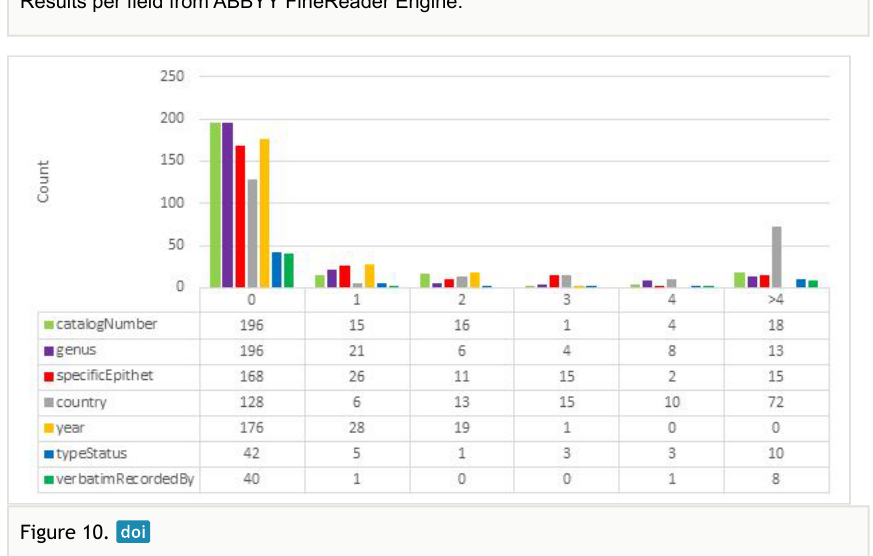
Results per field from Google Cloud